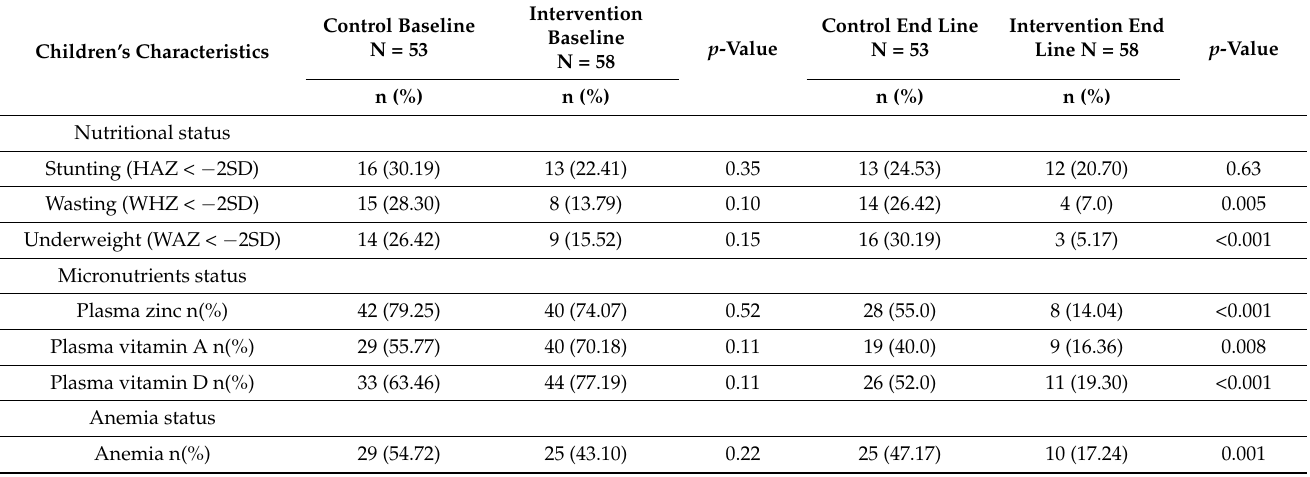
Table 6. Impact of MNP intervention on stunting, wasting, being underweight, micronutrient deficiencies, and anemia status in children at the baseline and end line of the